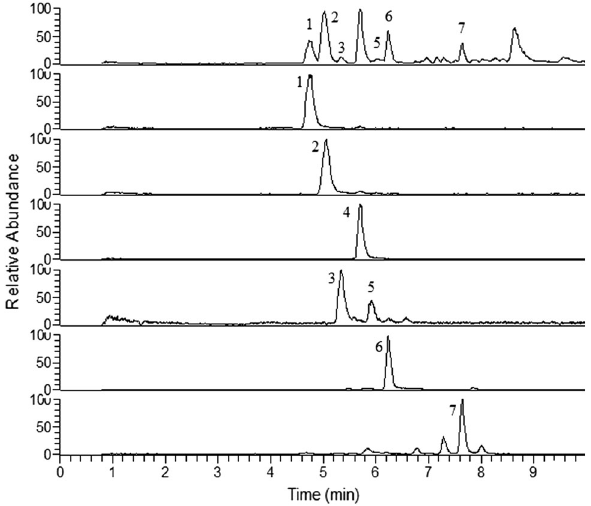
Fig. 2 UPLC-ESI-IT-MS analysis of the saponins present in Luidia senegalensis . Base Peak Ion—BPI (above) and extracted chro- matograms of the ions 1: m/z 1405; 2: m/z 1389; 4: m/z 1239; 3 and 5: 1227; 6: m/z 529; 7: m/z